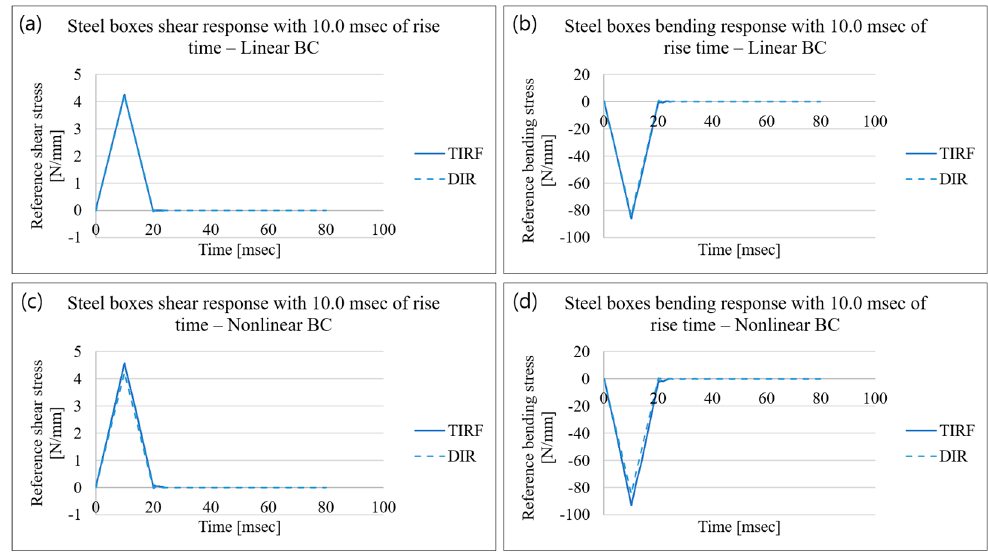
calculated results showed the TIRF was the conservative method. The corresponding Figure 8. Reference shear and bending responses using TIRF and DIR for impact pressure of 5.0 ms median values of the difference in the peak stress and impulse values with the nonlinear of rise time: ( a ) Reference shear responses with linear boundary conditions, ( b ) Reference bending boundary condition using the TIRF and DIR were − 5.4% and − 9.4%, respectively, as shown responses with linear boundary conditions, ( c ) Reference shear responses with nonlinear boundary in Figure 10. conditions, and ( d ) Reference bending responses with nonlinear boundary conditions.